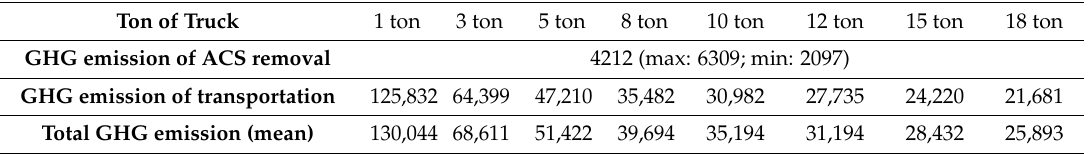
Table 11. Estimated GHG emission caused by the removal of all ACS in Korea (unit: tonCO 2